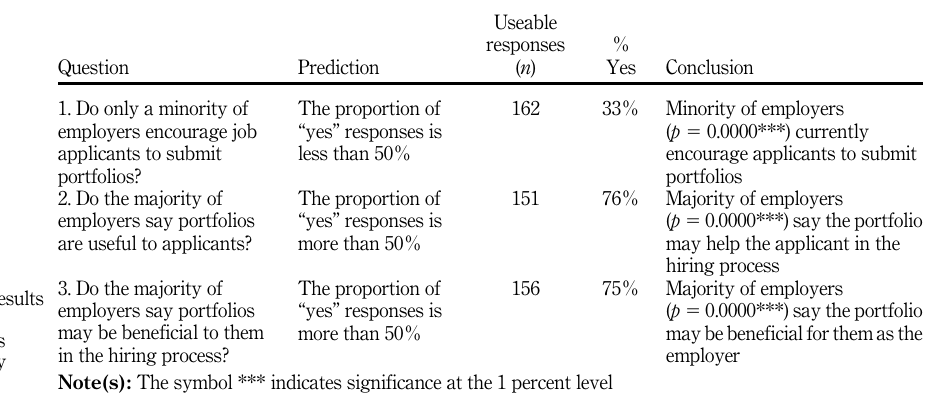
Table 3. One-tailed z test results of population proportions of yes answers to survey